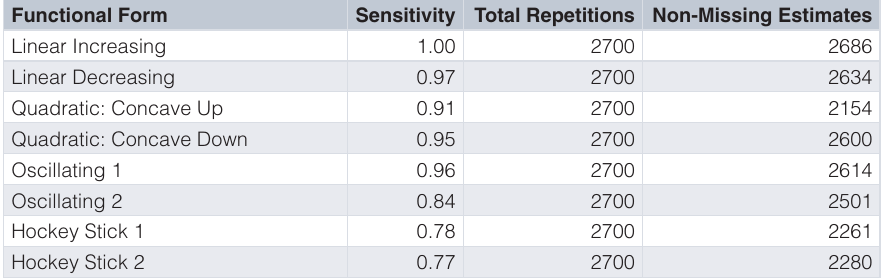
non-differential trends, Oscillating, and variable trends, Hockey Stick, had lower average sensitivity while the linear and quadratic trends tended to perform the